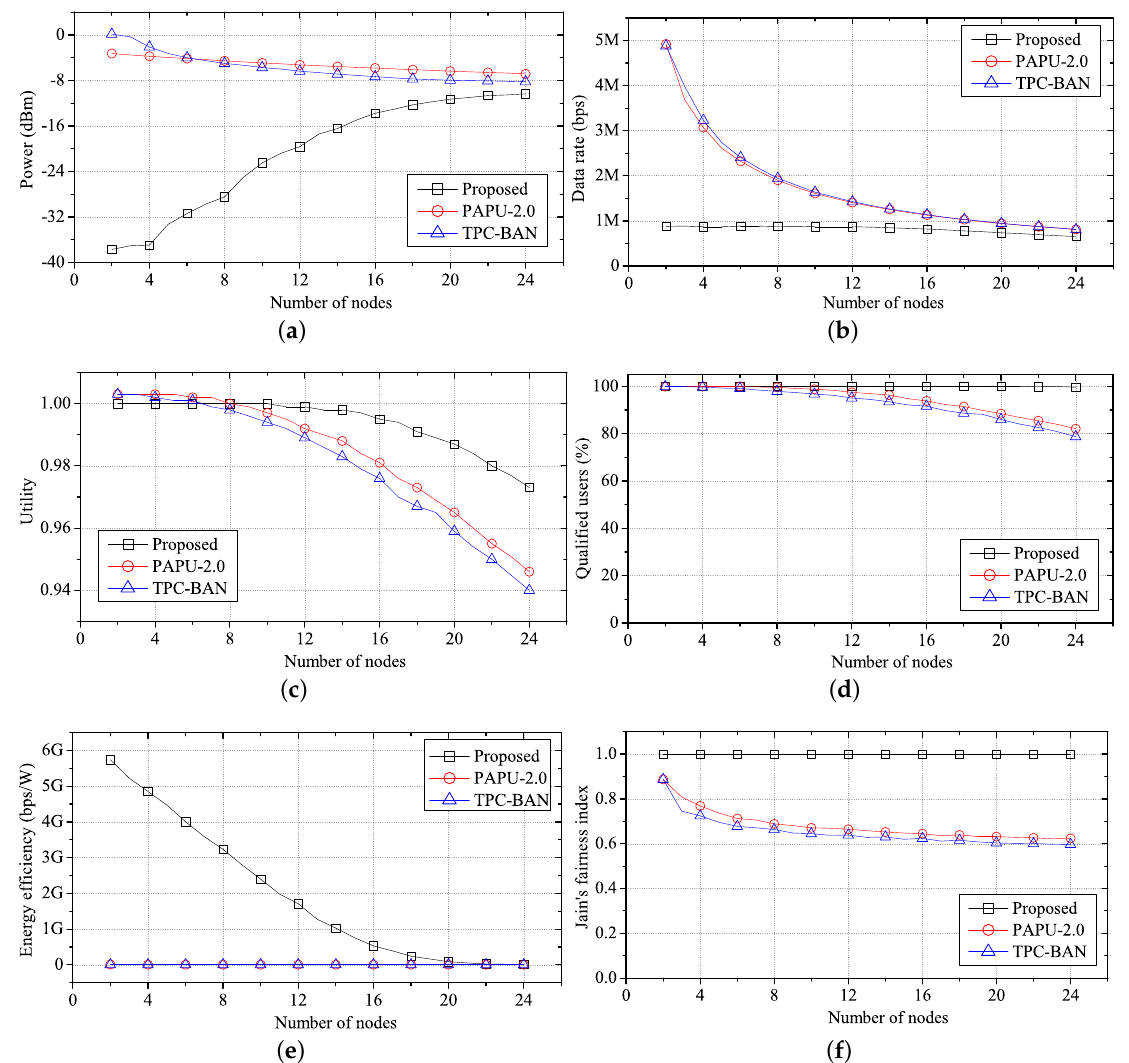
Figure 11. Performance of FTPC-U compared with PAPU and TPC-BAN according to the number of nodes. ( a ) Change in average transmit power; ( b ) change in average data rate; ( c ) change in average utility; ( d ) change in qualified users; ( e ) change in average energy efficiency; ( f ) change in